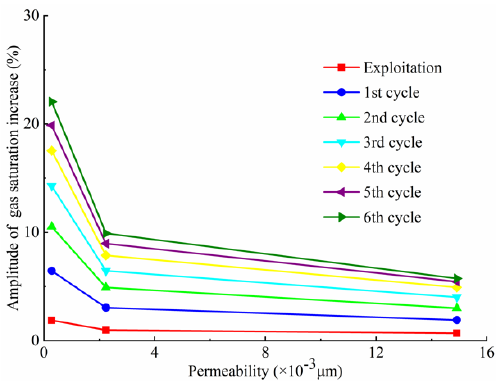
Figure 6. The relation curve between gas saturation and permeability